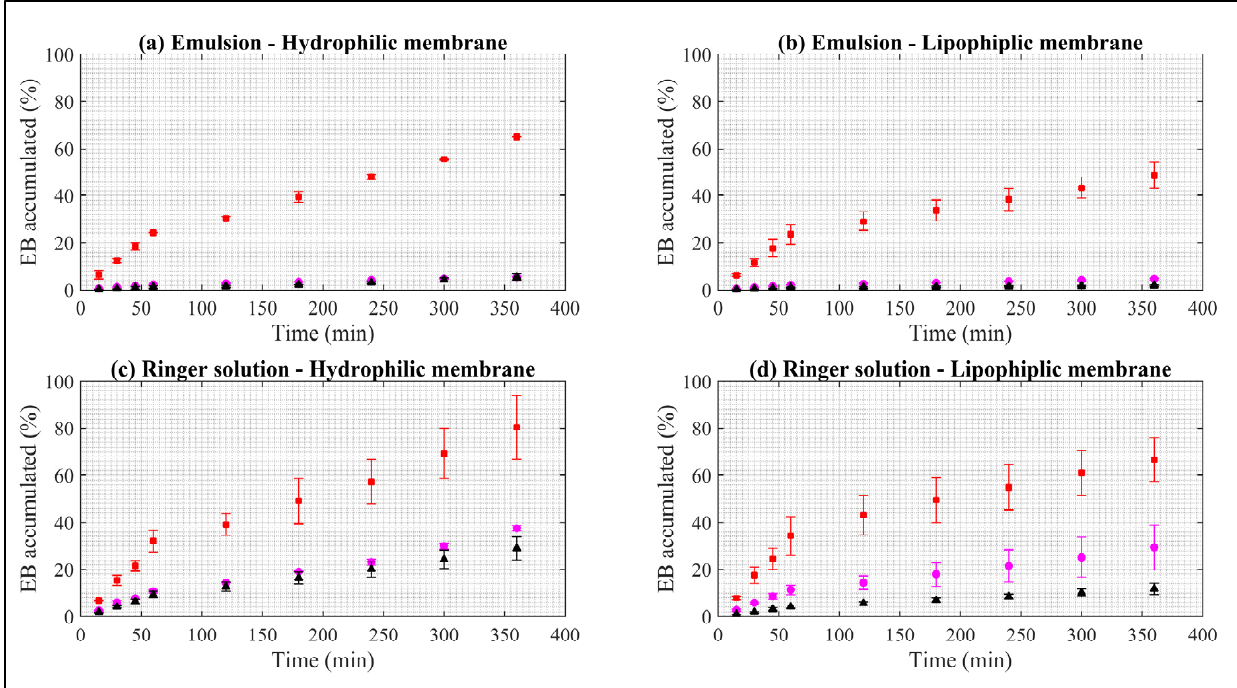
Figure A1. Dissolution rate of EB in synthetic membranes. Red squares represent EB–ALG microparticles, black triangles represent EB–SOL microparticles, and magenta circles represent free EB. ( a ) Represents emulsion as donor media with hydrophilic membrane. ( b ) Represents emulsion as donor media with lipophilic membrane. ( c ) Represents Ringer solution as donor media with hydrophilic membrane. ( d ) Represents Ringer solution as donor media with lipophilic membrane. Values represent the mean with standard deviation, n = 3.